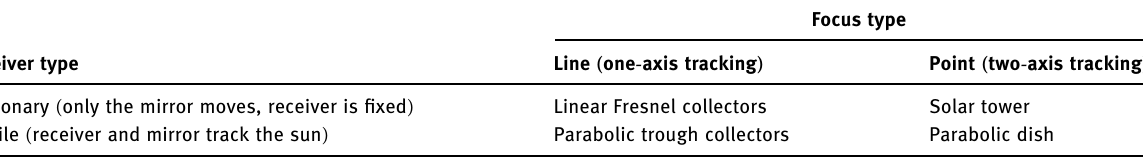
Table 1: Characteristics of solar concentrating technologies [ 2